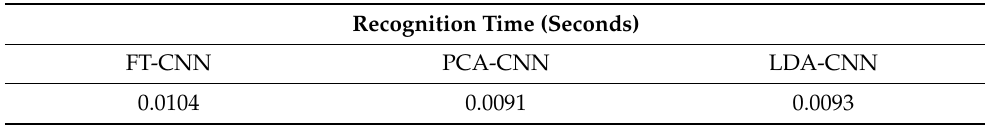
Figure 14. The performance comparison of FT-CNN, PCA-CNN and LDA-CNN models using different backbone models on the UFPR dataset. Table 14. Comparison of the average recognition time needed by FT-CNN, PCA-CNN and LDA-CNN models using UFPR